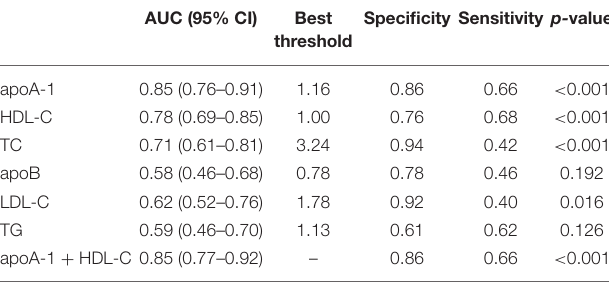
TABLE 3 | Diagnostic values of lipid profiles in assessment of COVID-19 severity.